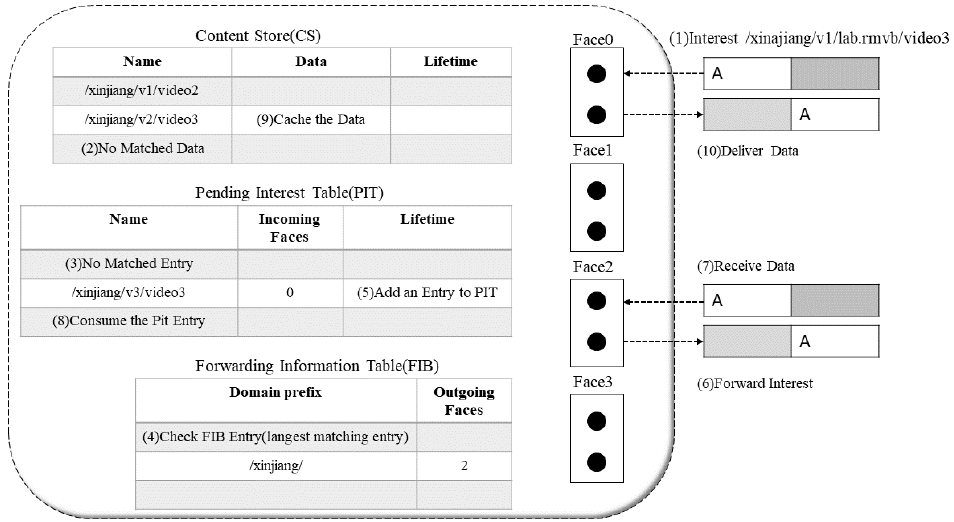
Figure 2. NDN forwarding model.